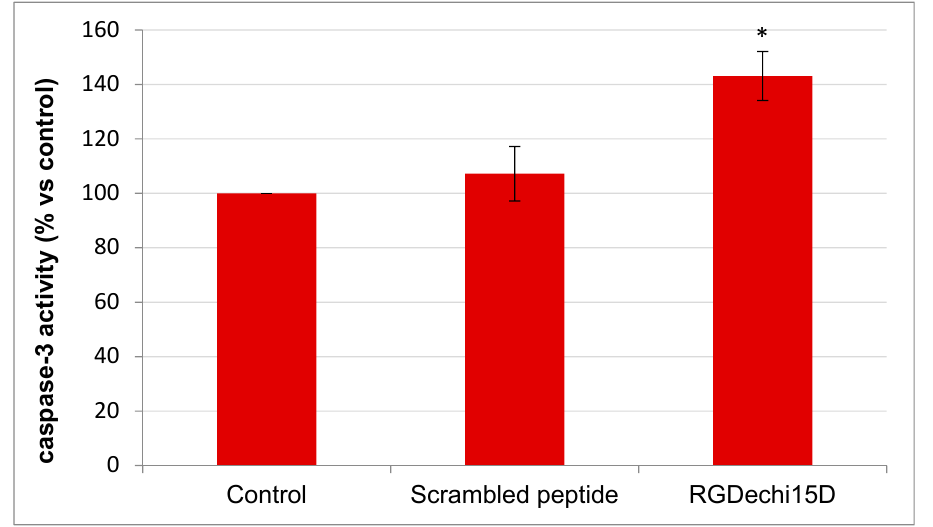
Figure 9. Apoptosis assay. Caspase-3 activity on HepG2 was determined after incubation with peptides (50 µM) for 6 h. Caspase-3 activity (calculated as nmol 7-Amino-4-trifluoromethylcoumarin (AFC)/min/µg protein) was expressed as the percentage of caspase-3 activity with respect to control (untreated cells). The results are expressed as means ± SE of at least three independent experiments